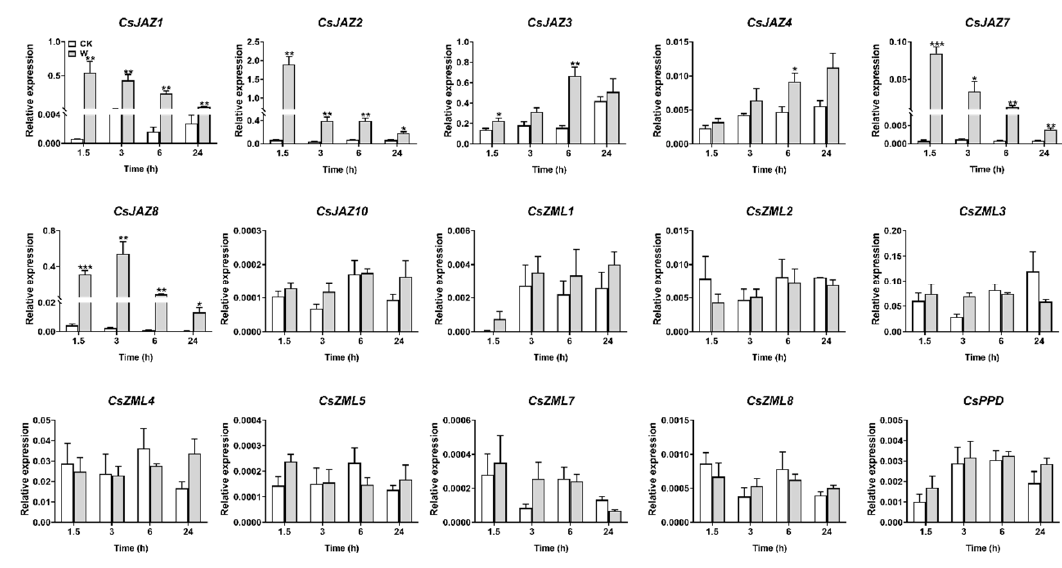
Figure 6. Expression profile of CsTIFY genes elicited by mechanical wounding. Data are shown by the mean + SE, asterisks indicate significant difference between treatment and control (Student’s t -test, * p < 0.05, ** p < 0.01, *** p < 0.001, n = 6).